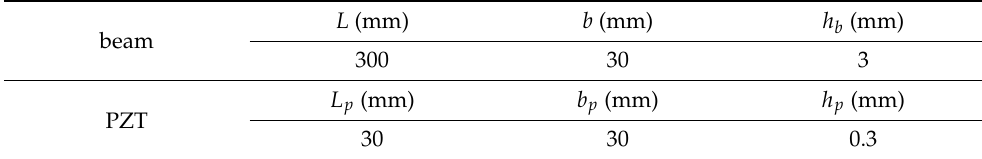
Table 1. Geometric details of the beam and each PZT actuator.